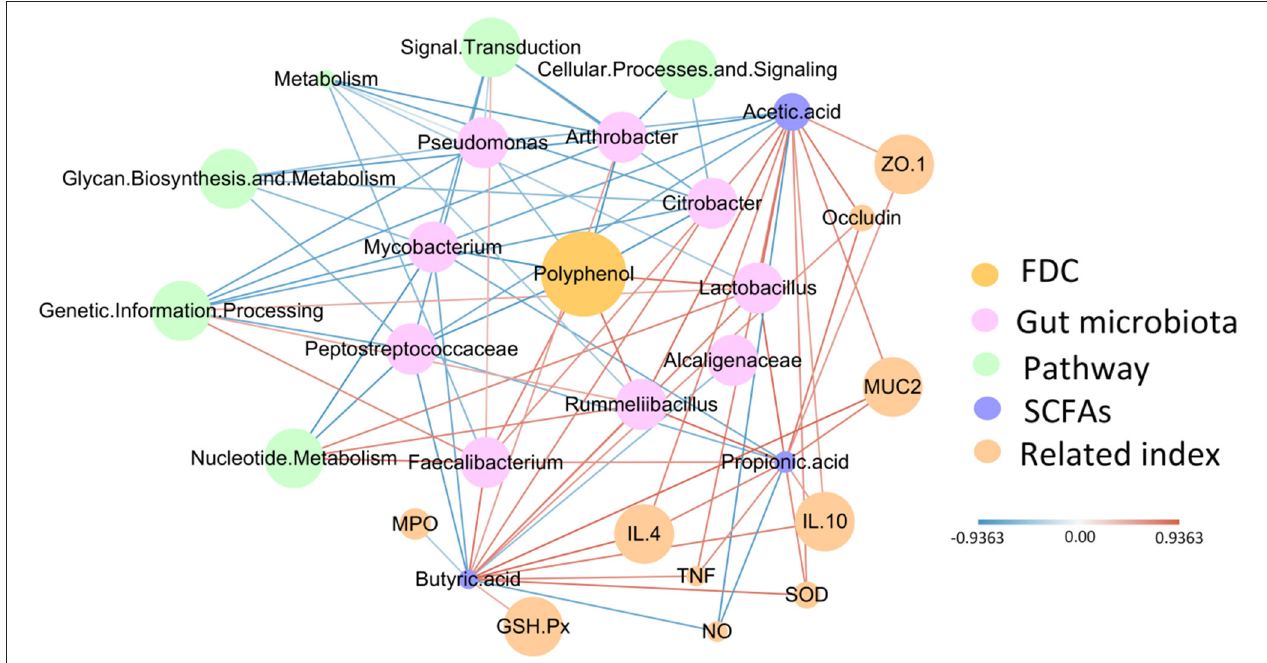
FIGURE 8 | The correlation network constructed with polyphenols, bacterial species, microbial metabolic pathways, SCFAs, the immune index, biomarkers of oxidative stress and the physical barrier index. The edge width and color (red, positive and blue, negative) are proportional to the correlation strength. The node size is proportional to the relative mean